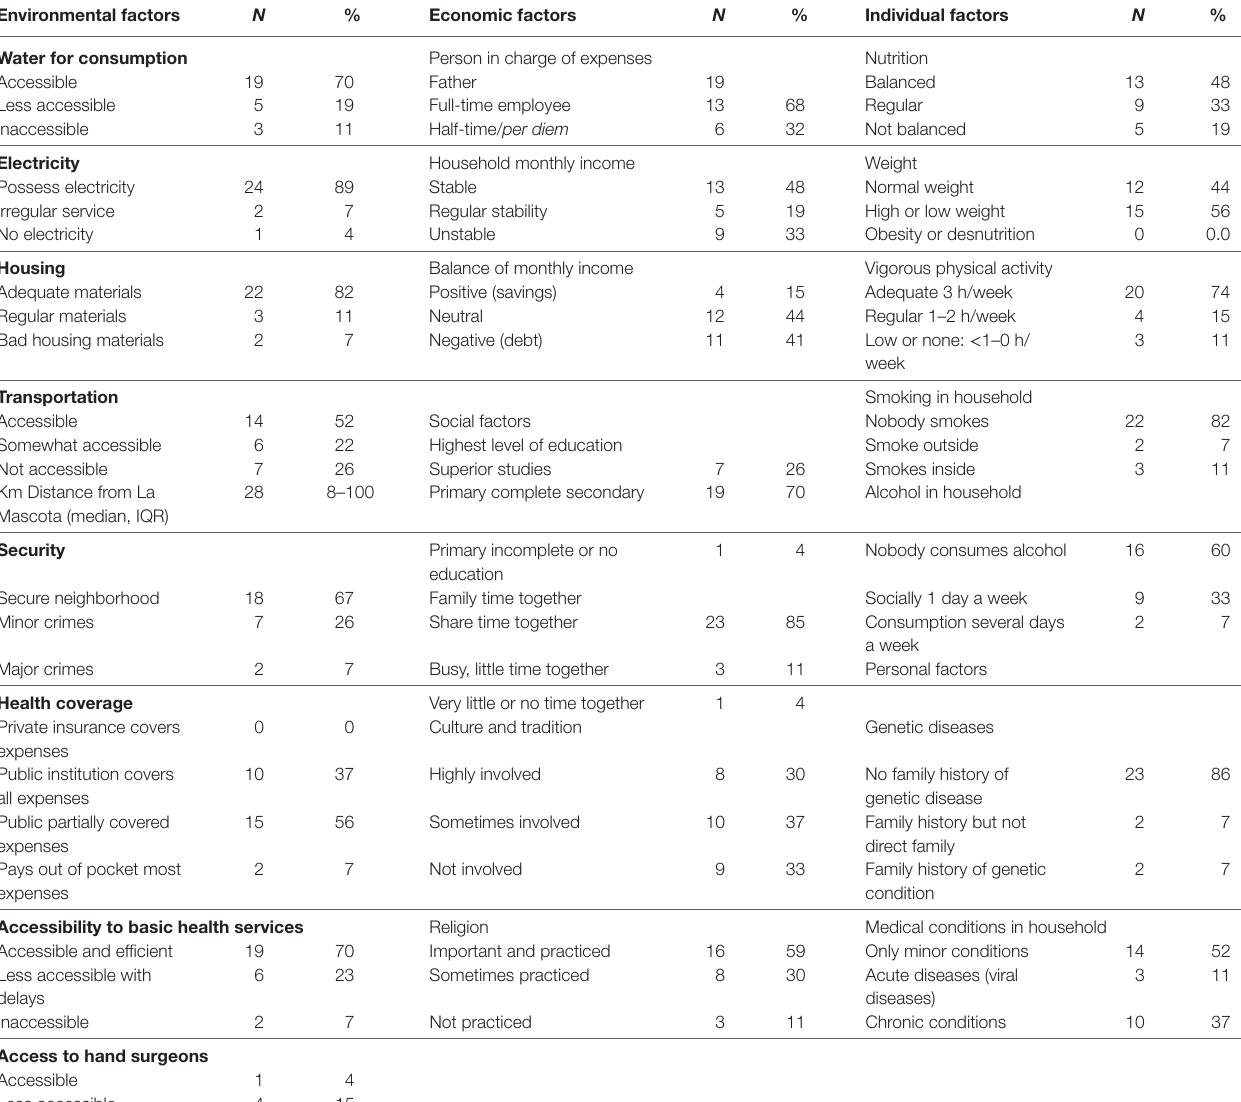
taBLe 2 | Factors determinants of health derived from interviews to 27 parents of children with congenital upper limb differences in La mascota